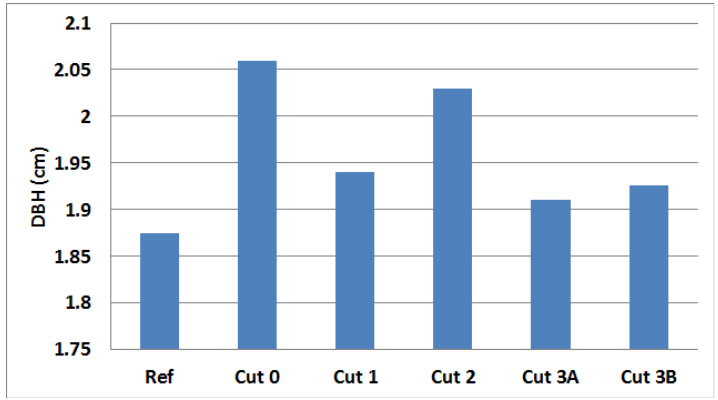
Figure 6. Diameter at breast height (DBH) of the aspen main branch. The reference (1.875 cm) was measured by averaging two calliper measurements taken at right-angles.